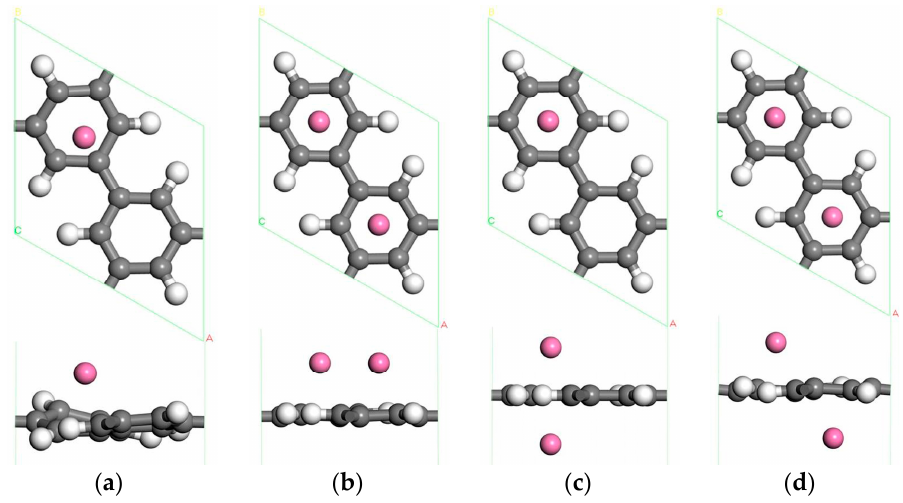
Figure 2. The optimized atomic structure of Sc atom decorated PG. ( a ) single Sc atom decorated PG; ( b ) two Sc atoms decorated single-sided PG; ( c ) two Sc atoms decorated double-sided PG at the same hole; ( d ) two Sc atoms decorated double-sided PG at the adjacent hole. The gray, white and pink balls in this and following figures denote C, H and Sc atoms, respectively.